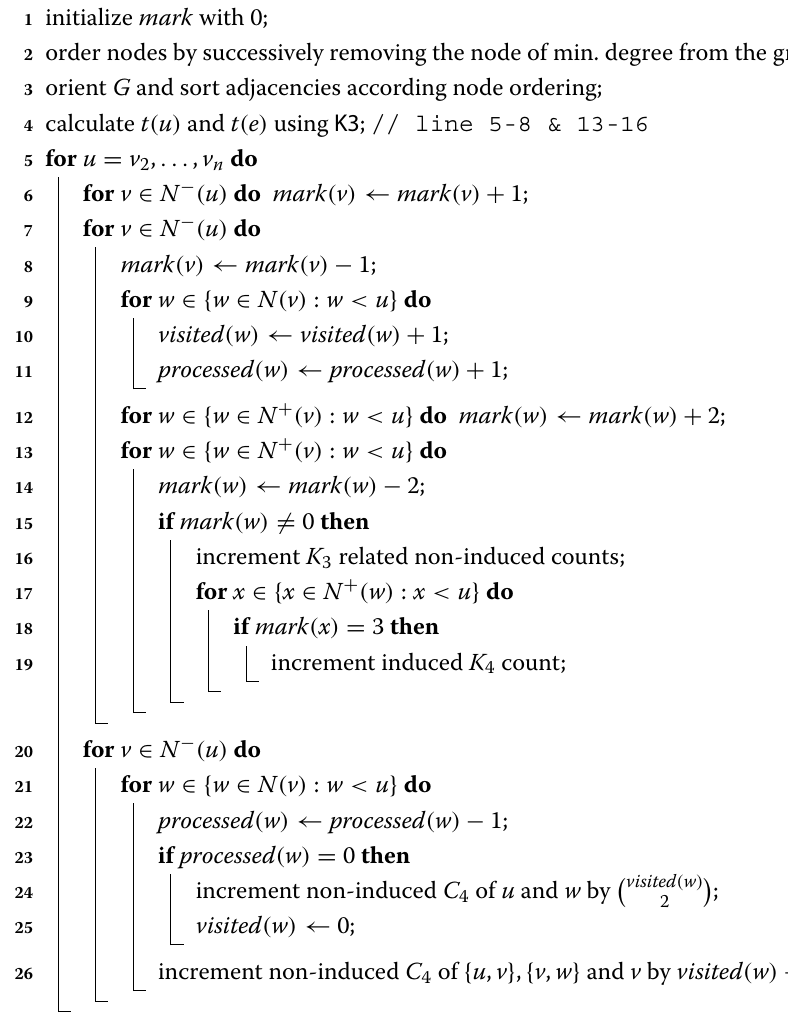
Algorithm 1: K3 / C4 / COMPLETE (Chiba and Nishizeki